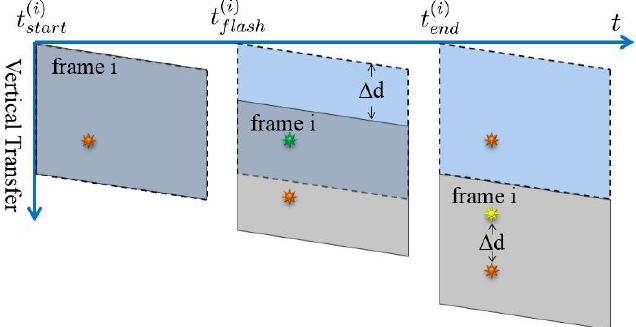
Figure 9. The generation process of the smear dot above the light source position. The orange sun symbol denotes the position of the light source in the image, and the yellow one represents the smear. When the strobe illuminates, the light source turns